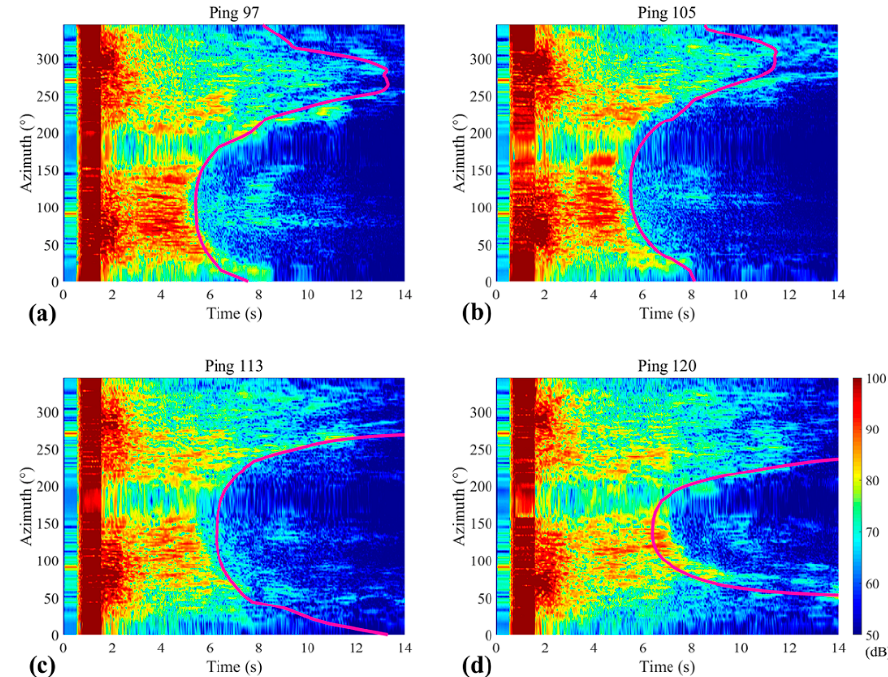
Figure 11. Comparison of measured BTRs and two-way MDP travel time+ curves: ( a ) ping 97, ( b ) ping 105, ( c ) ping 113, and ( d ) ping 120. These pings have a pulse length of 1.0 s.